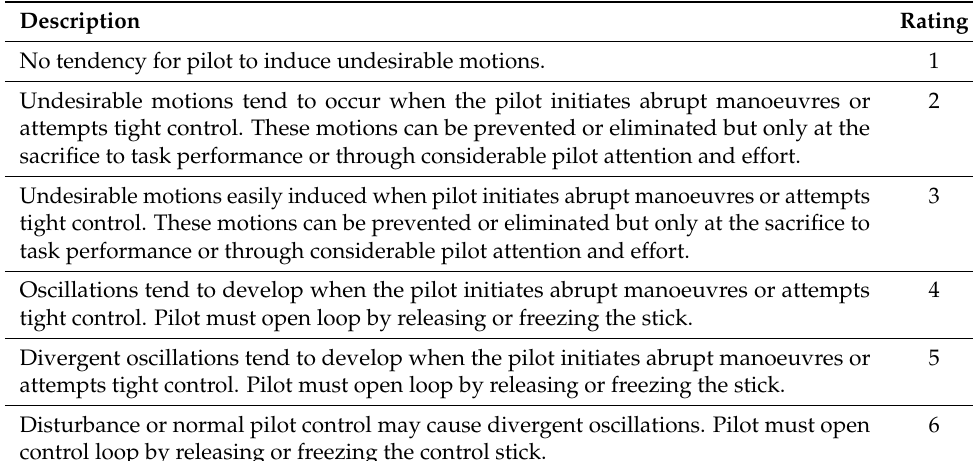
Table 3. Pilot-Induced Oscillation (PIO) Rating Scale. Reproduced from